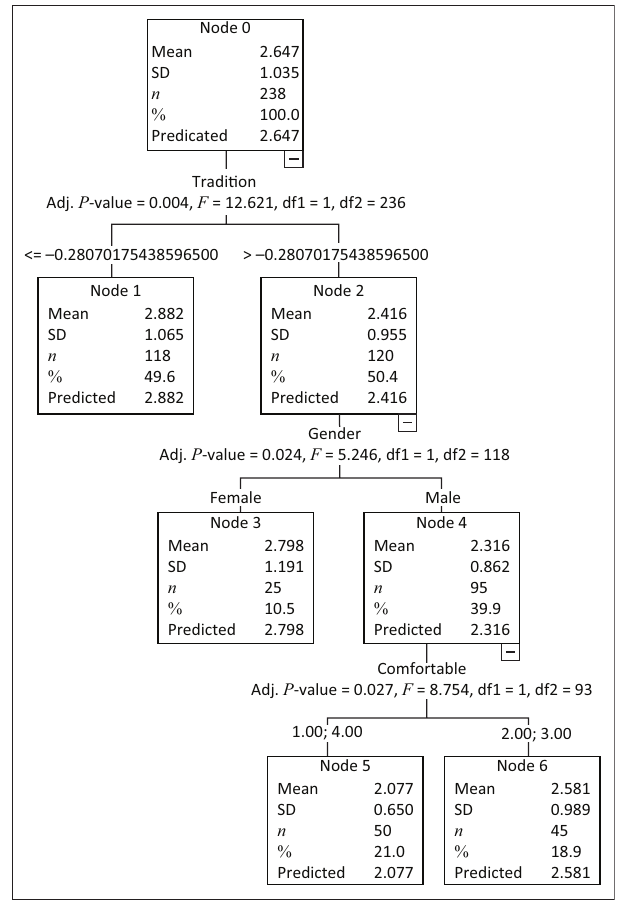
SD, standard deviation. FIG URE 2: Decision tree analysis for the tradition value in conservation for scenario 1. M = 2.8, p ˂ 0.05). Decision comfort also featured with the respondents most comfortable with their decision-making displaying lower quality decisions ( M = 2.1, SD = 0.7 vs. M = 2.6, SD = 1.0, p ˂ 0.05). The results show that the lower quality decisions were made by tradition-oriented male participants, most comfortable with their decisions ( M = 2.1, SD = 0.7).